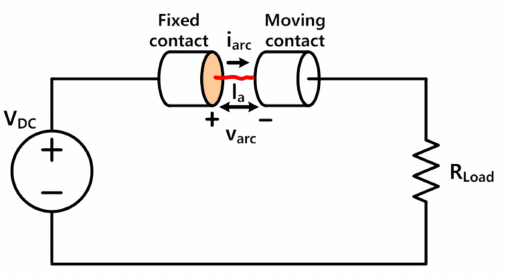
Figure 1. Schematic power circuit with pure contact type DC